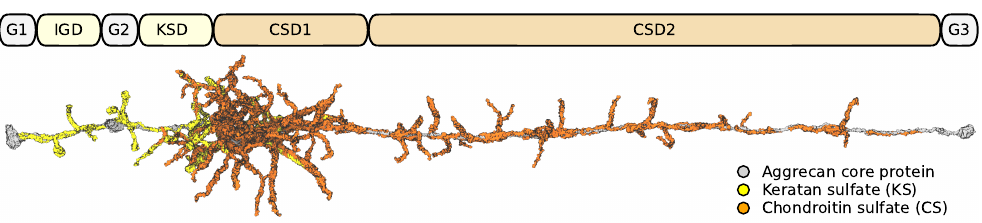
Figure 6. Structure of glycosylated aggrecan core protein showing the different domains. All domains with keratan sulfate or chondroitin sulfate glycosylations feature occasional ring piercings through the hexose carbohydrate